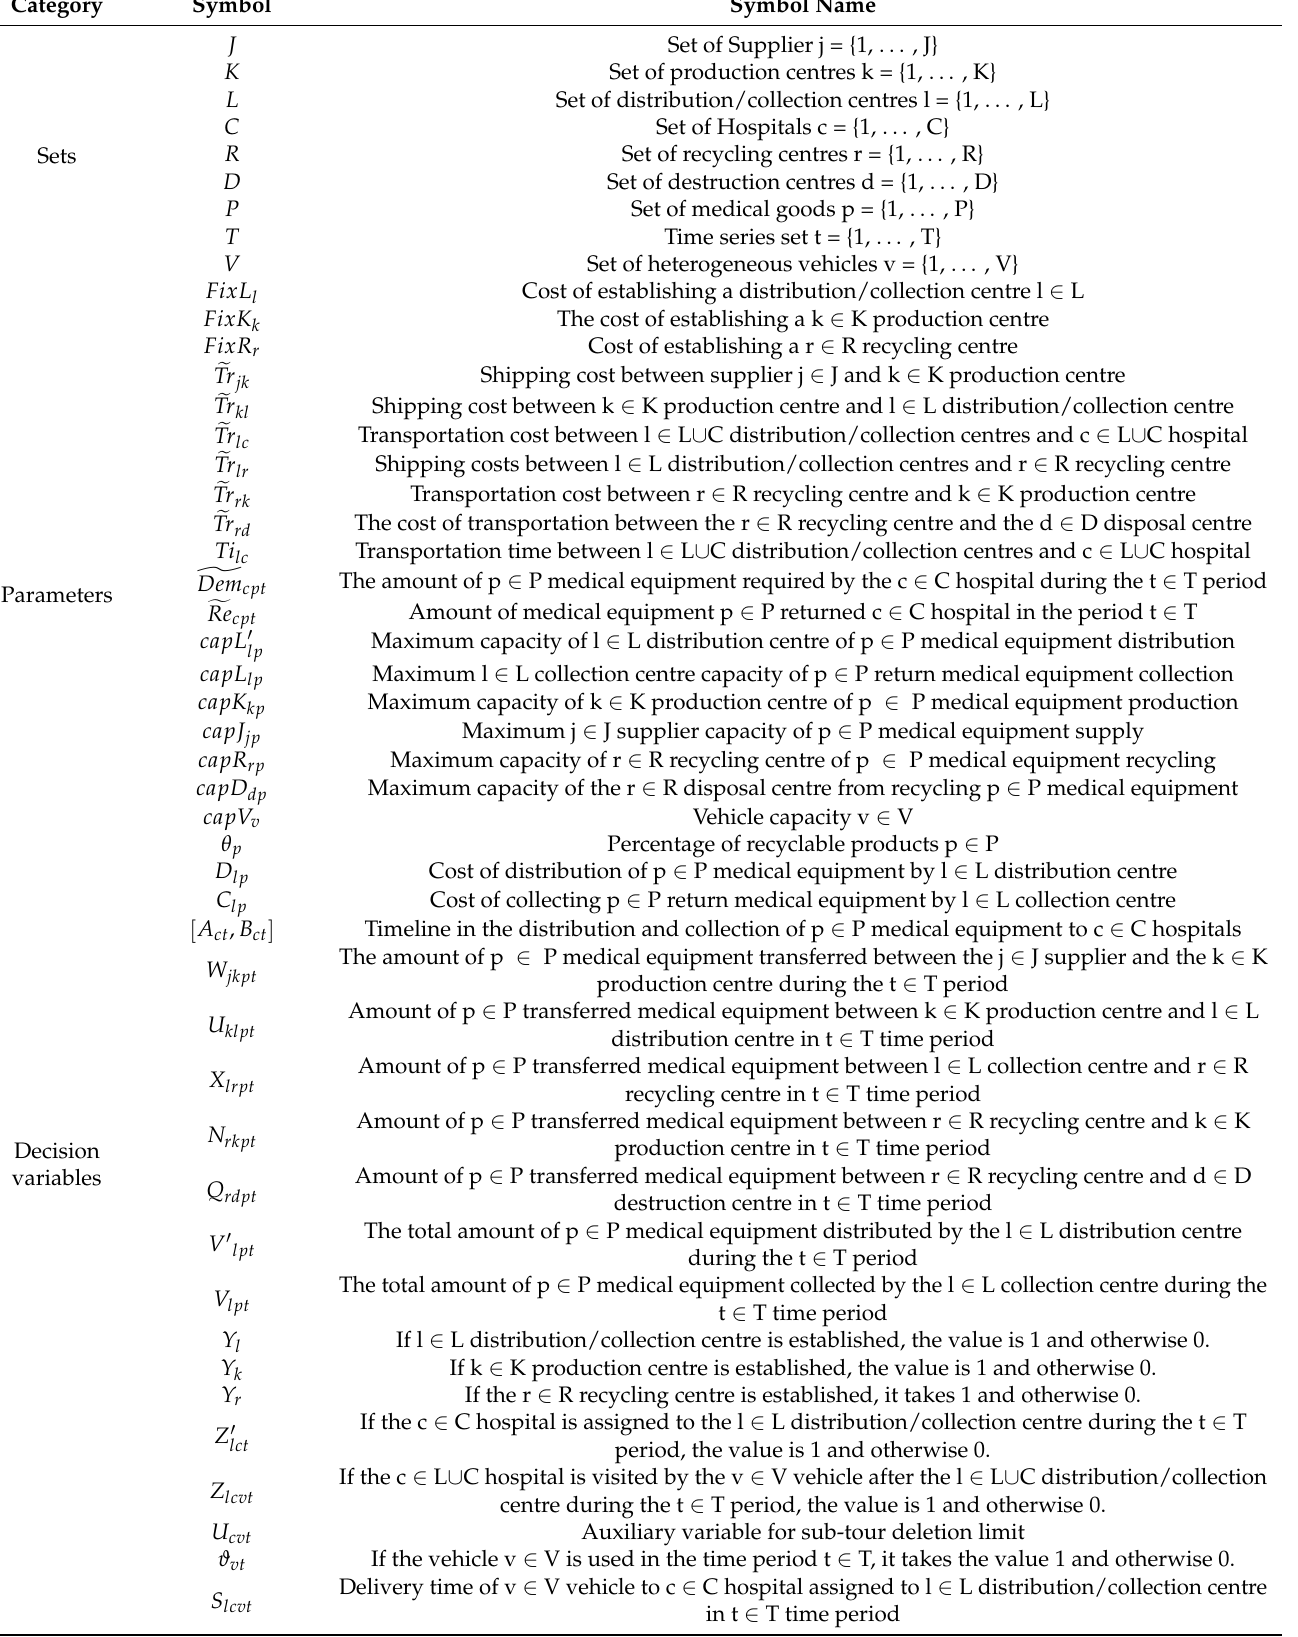
Table 2. Elements of the